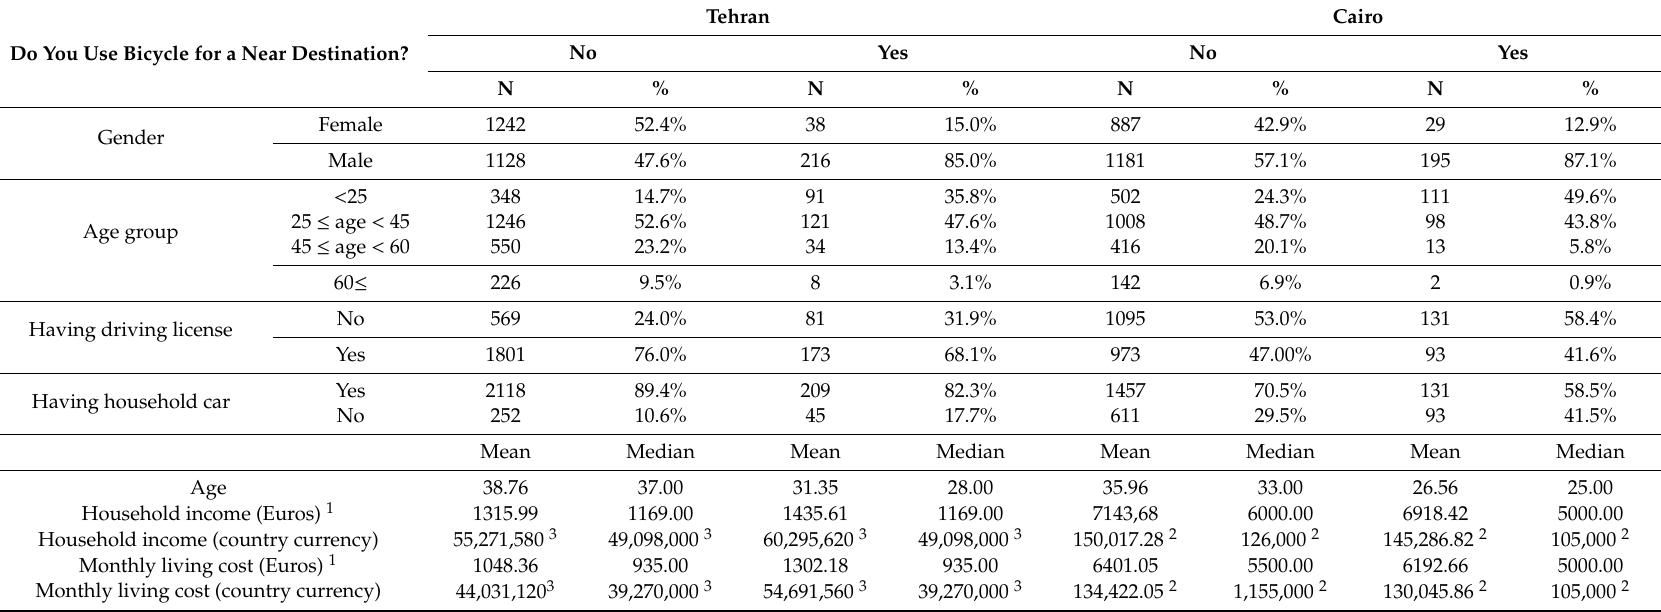
Table 1. The socio-economic parameters in the Tehran and Cairo